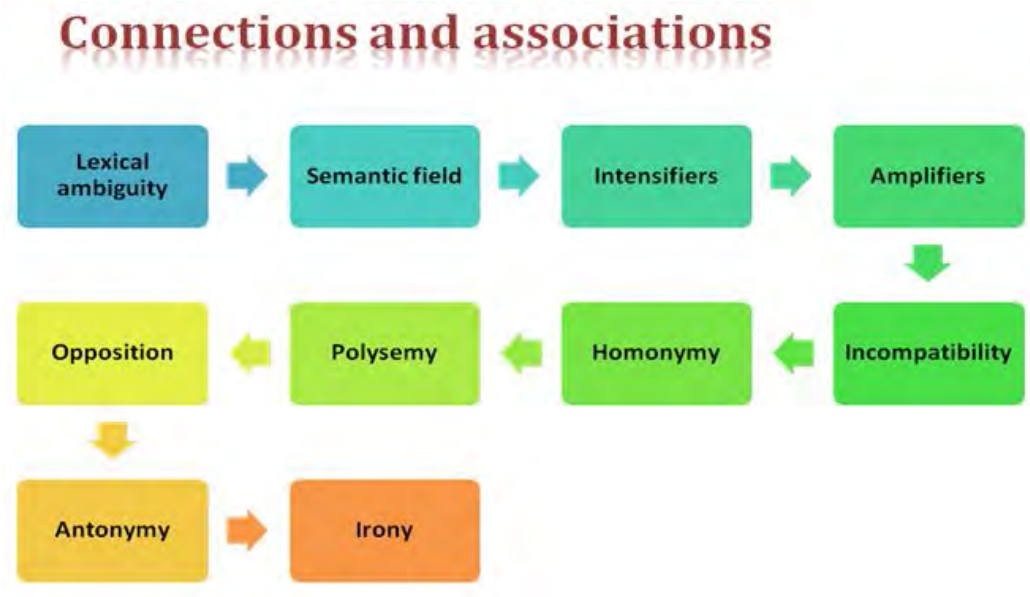
Fig. 1 – Associations of enantiosemy with other linguistic units